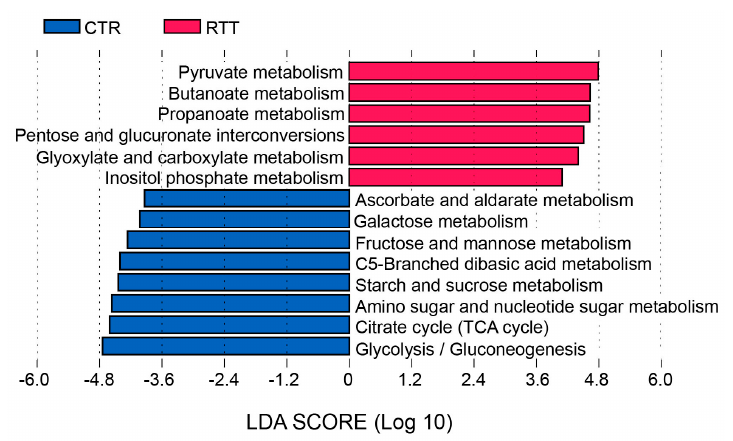
Figure 6. Functional characterization of carbohydrate metabolism, differentially represented in the gut microbiota of RTT and control subjects. Kyoto Encyclopedia of Genes and Genomes (KEGG) pathways have been identified by linear discriminant analysis coupled with effect size (LEfSe) (LDA > 2, p < 0.05). Magenta histograms: pathways enriched in RTT patients; blue histograms: pathways enriched in control subjects.